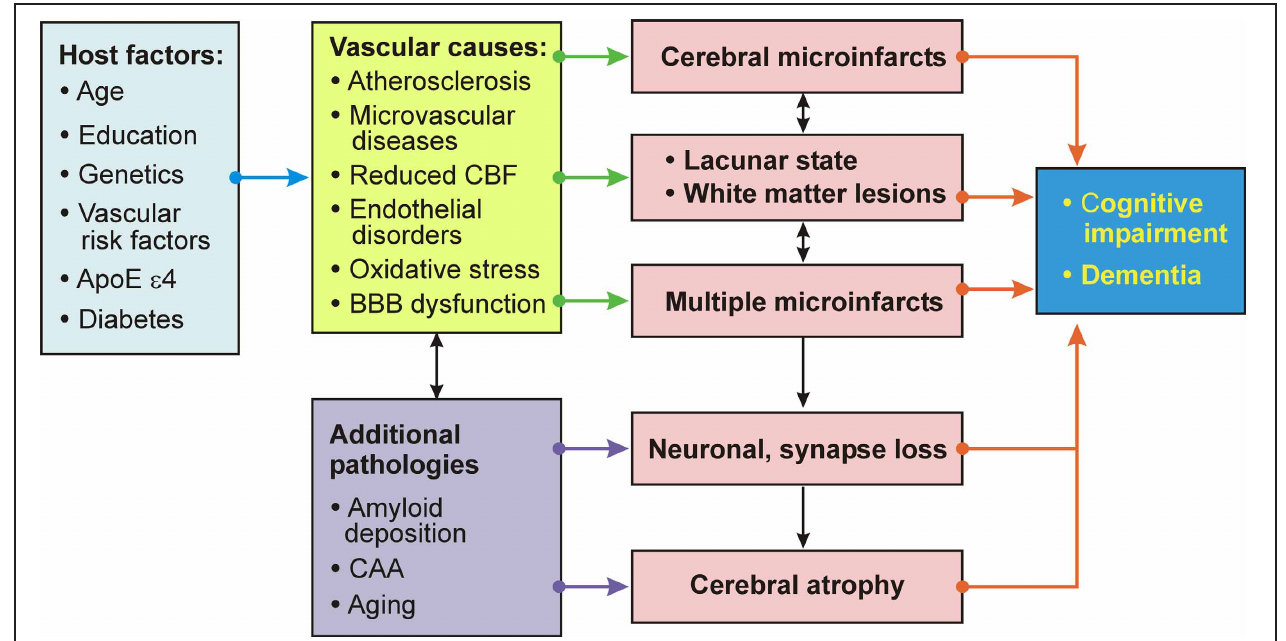
FIGURE 5 | Schematic interplay of pathogenic factors causing vascular cognitive